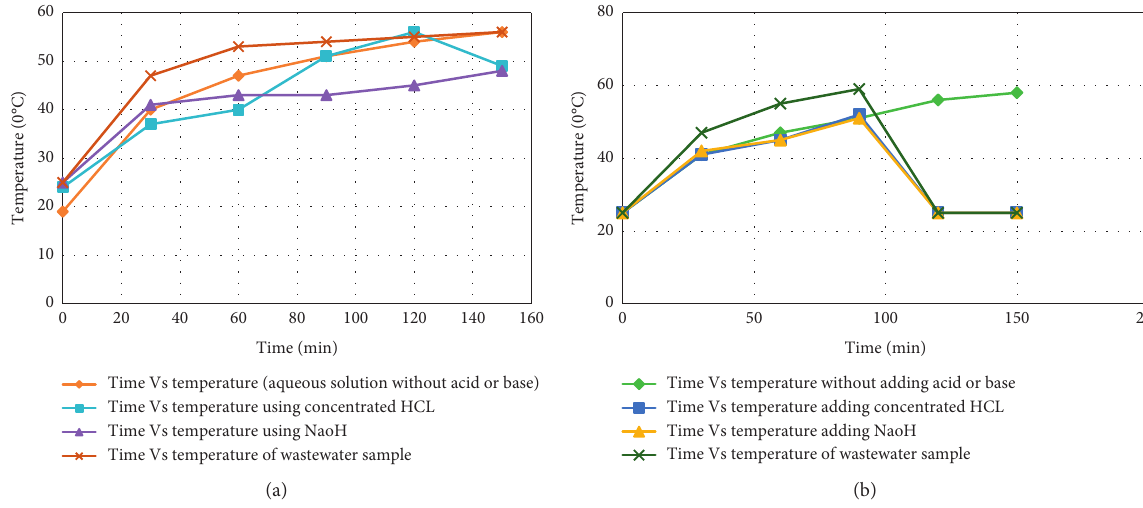
Figure 13: (a) Temperature variation graph with respect to time using the UEAR method. (b) Temperature variation graph with respect to time using the SER method.